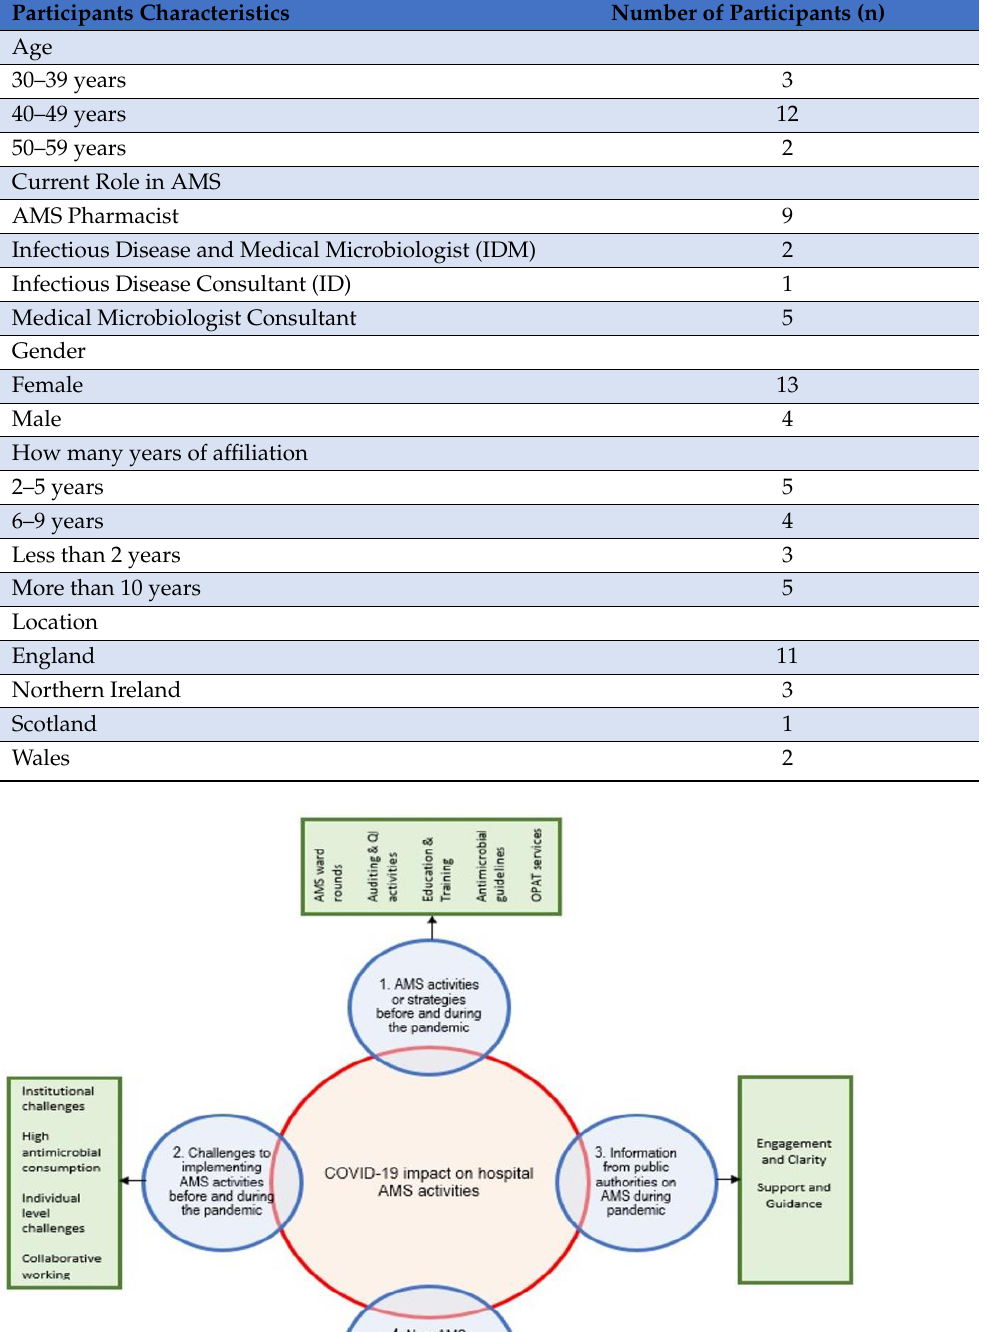
Table 1. Participants’ characteristics.